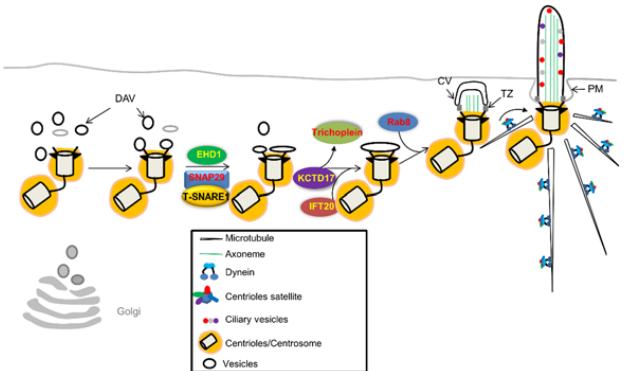
Figure 1 . A schematic of basal body docking and ciliogenesis. As the mother centriole begins its differentiation and migration to the cell surface it acquires distal appendenges and distal appendage vesicles (DAV) from the golgi. Proteins such as EHD1 in conjunction with Rab8 help to expand the DAV into a ciliary vesicle (CV). As ciliogenesis continues the basal body acquires positive regulators of ciliogenesis and removes negative regulators such as Trichoplein, allowing docking and the formation of the transition zone (TZ). Once the basal body docks at the plasma membrane (PM) axonemal extension can take place into the extra ‐ cellular space.